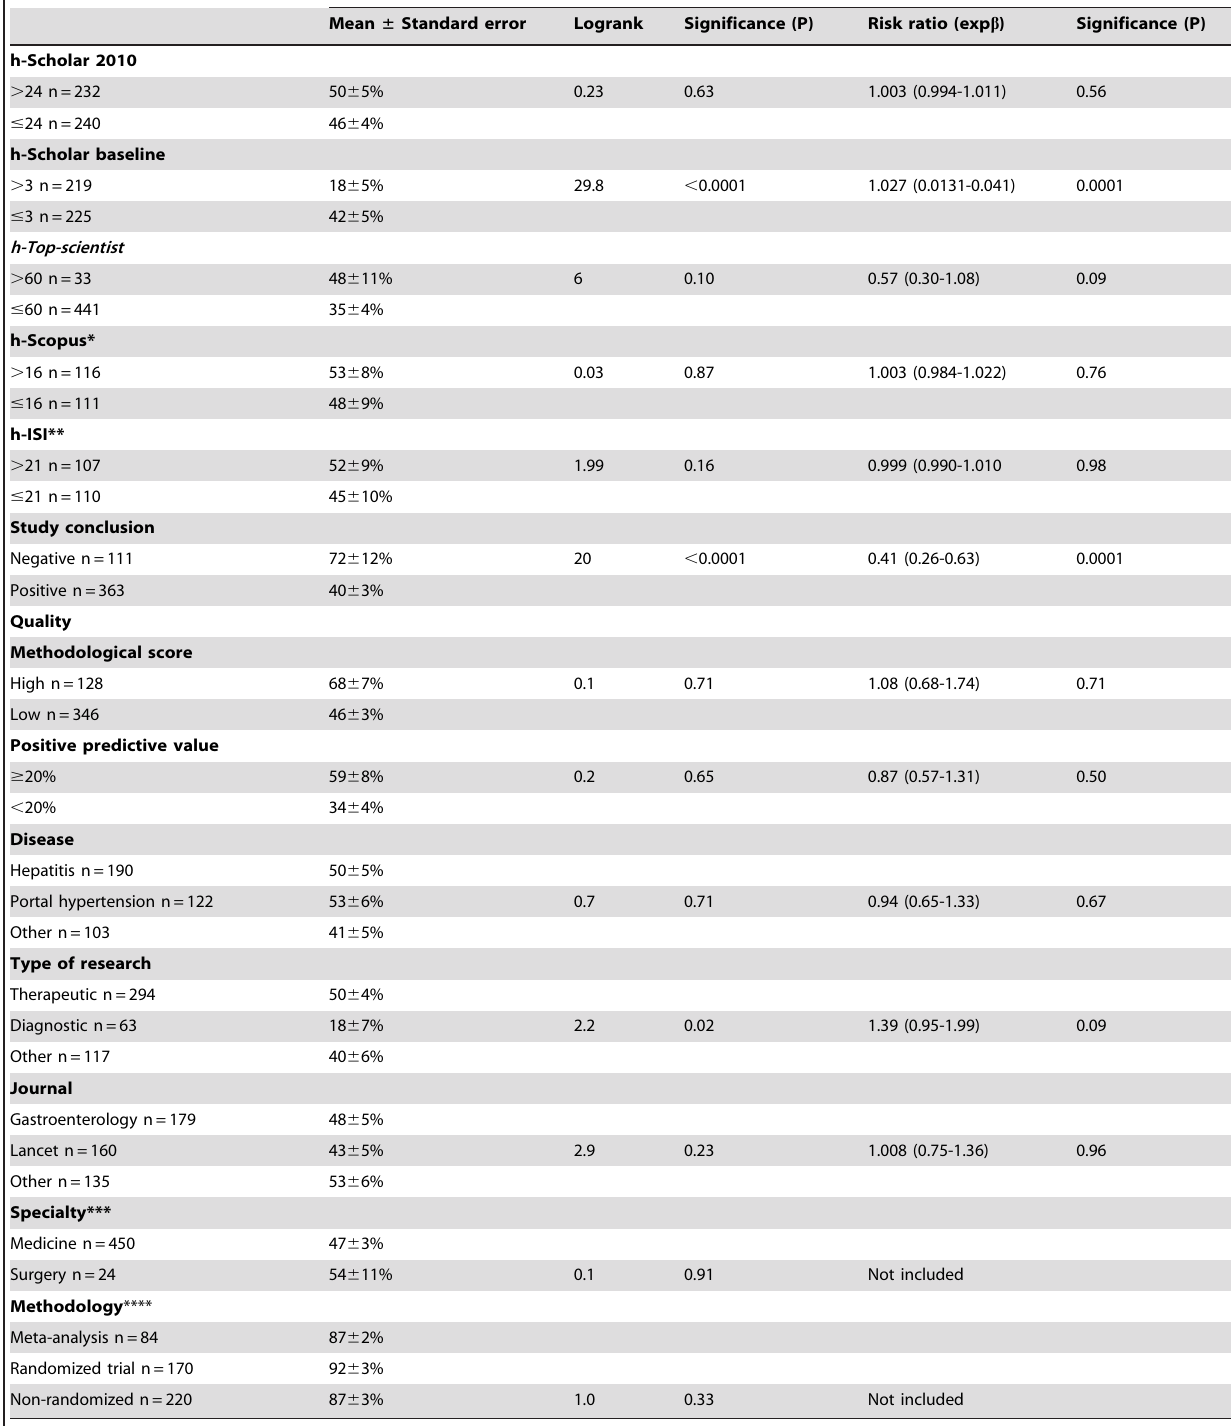
Table 5. Factors associated with truth